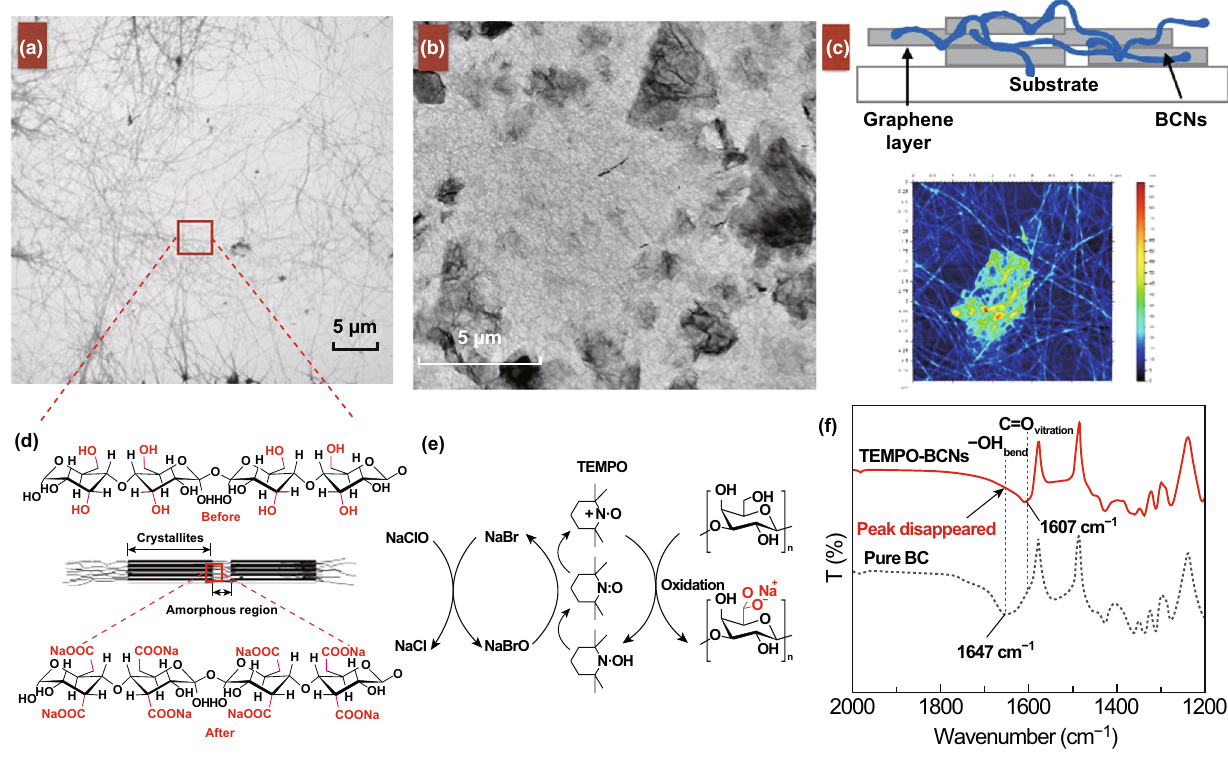
Fig. 4 a TEM image of BCNs derived from BC gels. b TEM image of a graphene-BCN membrane. c AFM image of the structure of the graphene-BCN sensor. d Molecular structure of BCNs before and after modification with TEMPO. e Chemical reaction on BCNs caused by TEMPO-modification. f FTIR spectra of pristine BCNs and modified BCNs. Adapted with permission from Ref. [197]. Copyright 2017